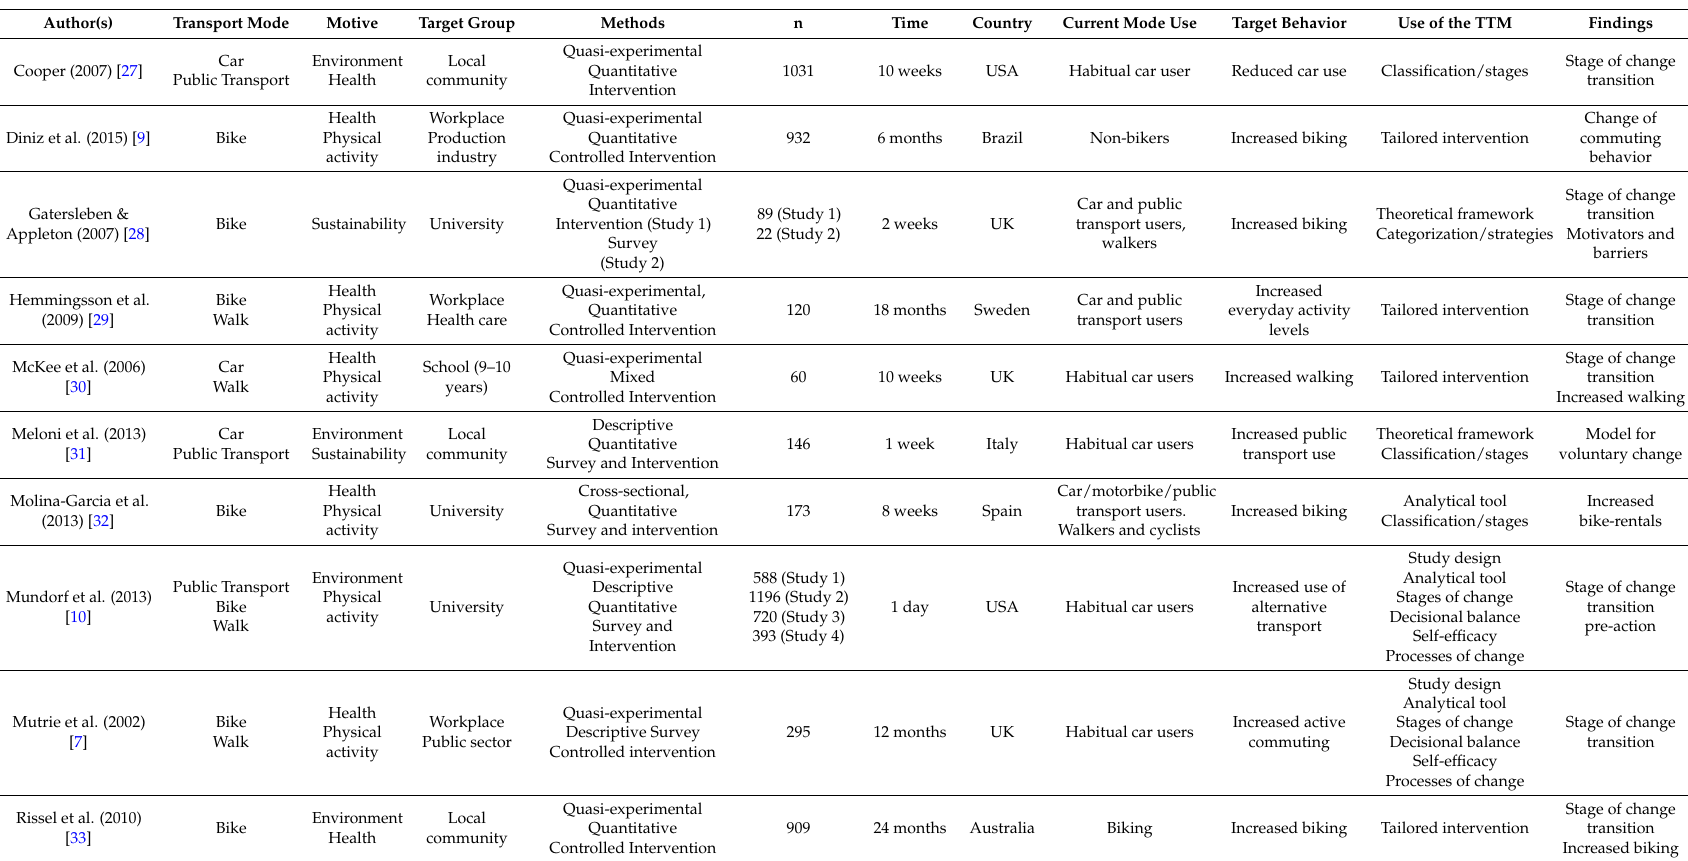
Table 3. Overview of the included intervention